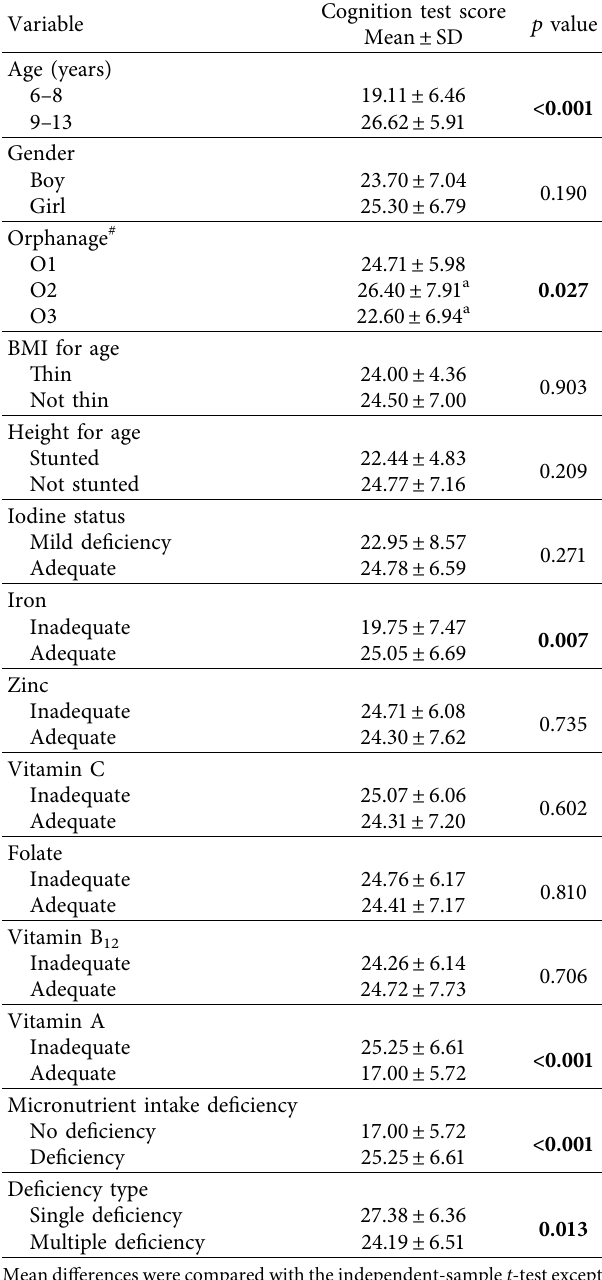
Table 4: Comparing mean cognition test scores. Table 5: Correlation between dietary micronutrient intake, urinary iodine levels, and cognition test scores.